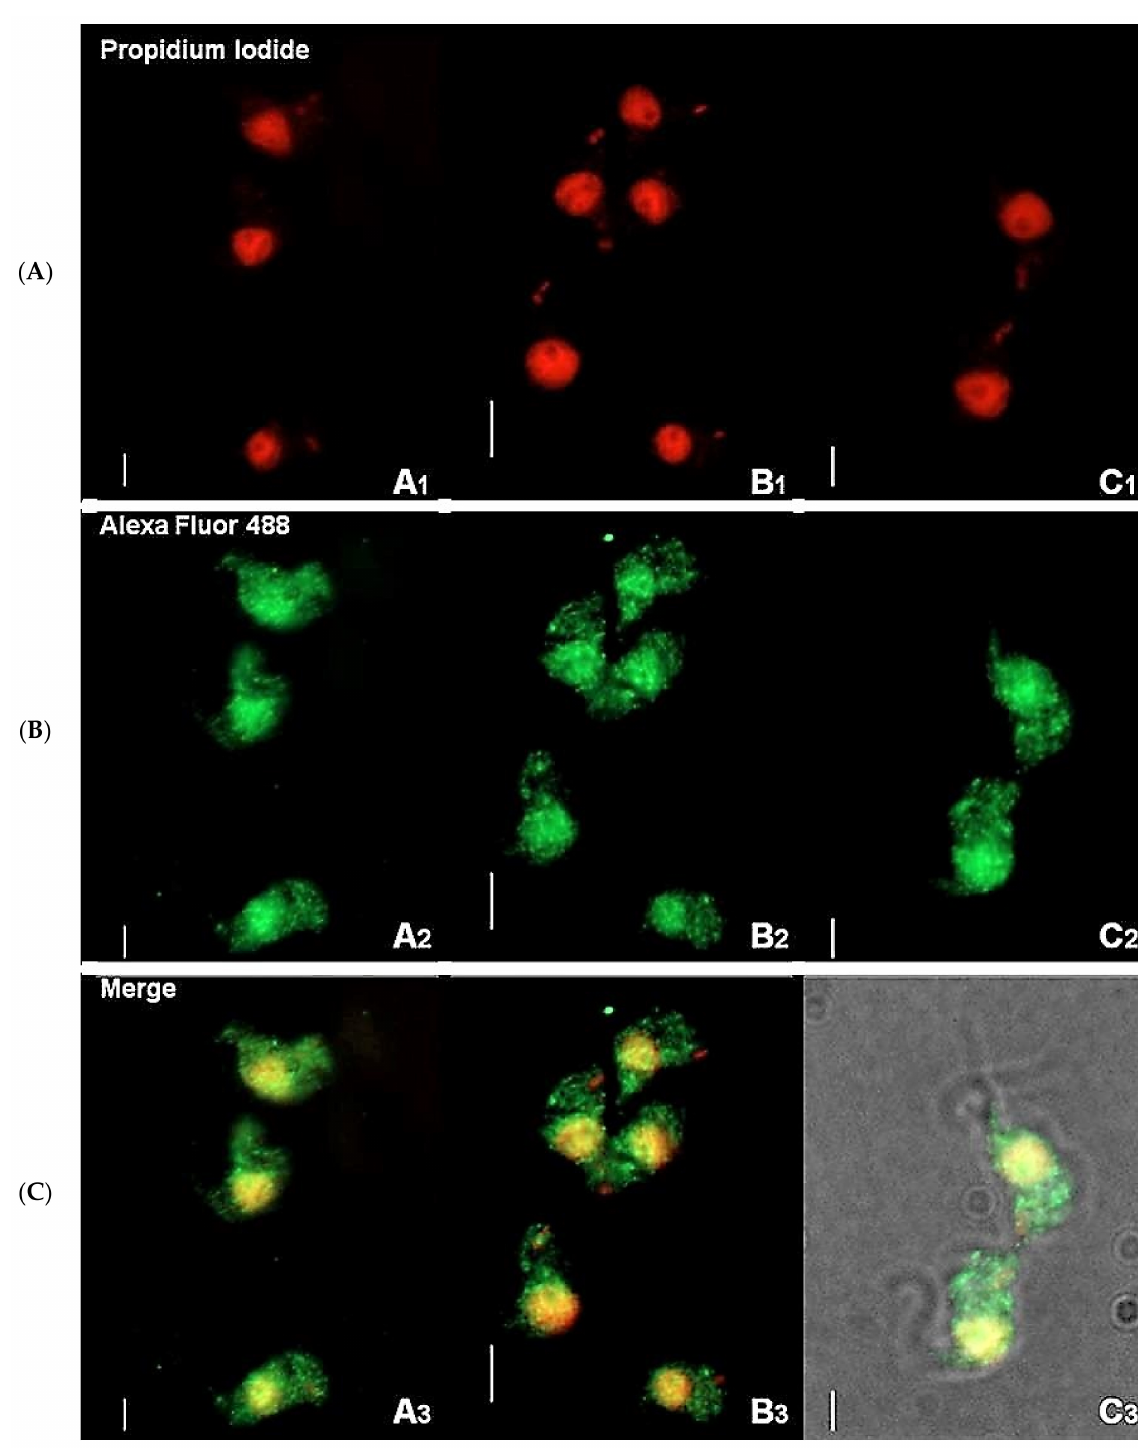
Figure 1. Immunofluorescence staining of T. brucei bloodstream form suggests cytosolic localization of TbHsp70.c. Dis- tribution of TbHsp70.c in T. b. brucei cells using TbHsp70.c primary antibody, and Alexa Fluor 488 secondary antibody ( A – C ). Parasite DNA was stained with propidium iodide. Upright scale bar, 5 µ m. Rows: Propidium iodide—parasite DNA, including the nucleus and kinetoplast detected with a UV filter, shown in red; Alexa Fluor 488—localization of TbHsp70.c; Merge—amalgamated image of DNA staining and TbHsp70.c